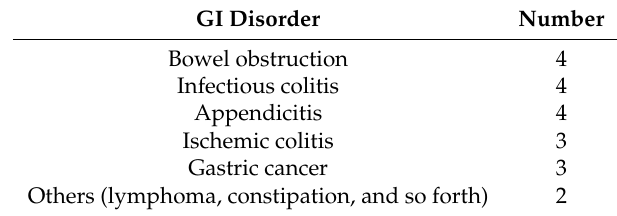
Table 4. GI disorders diagnosed by the hands-on seminar participants ( n =